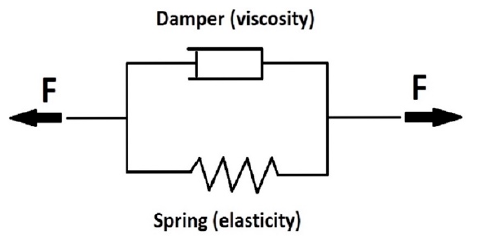
Figure 2. Scheme of Kelvin rheological model—parallel connection of spring and damper.